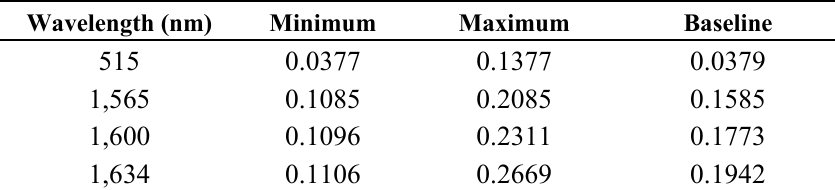
Table 1. The minimum, maximum and baseline of the surface albedo at 515, 1,565, 1,600, and 1,634 nm used in forward modeling calculations to derive the standard deviation in transmittance at these wavelengths due to changing surface conditions. Baseline values are from measurements over a vegetated surface [19] and are a subset of the full spectrum shown in Figure 3 (black curve). The minimum and maximum values represent 0.05 magnitude errors and 2% to 28% change in spectral slope across the 1,565 nm to 1,634 nm wavelength range relative to the baseline (see text). These values are typical of errors in satellite retrievals of surface albedo and of the variability in bare soil and vegetated surface types shown in Figure